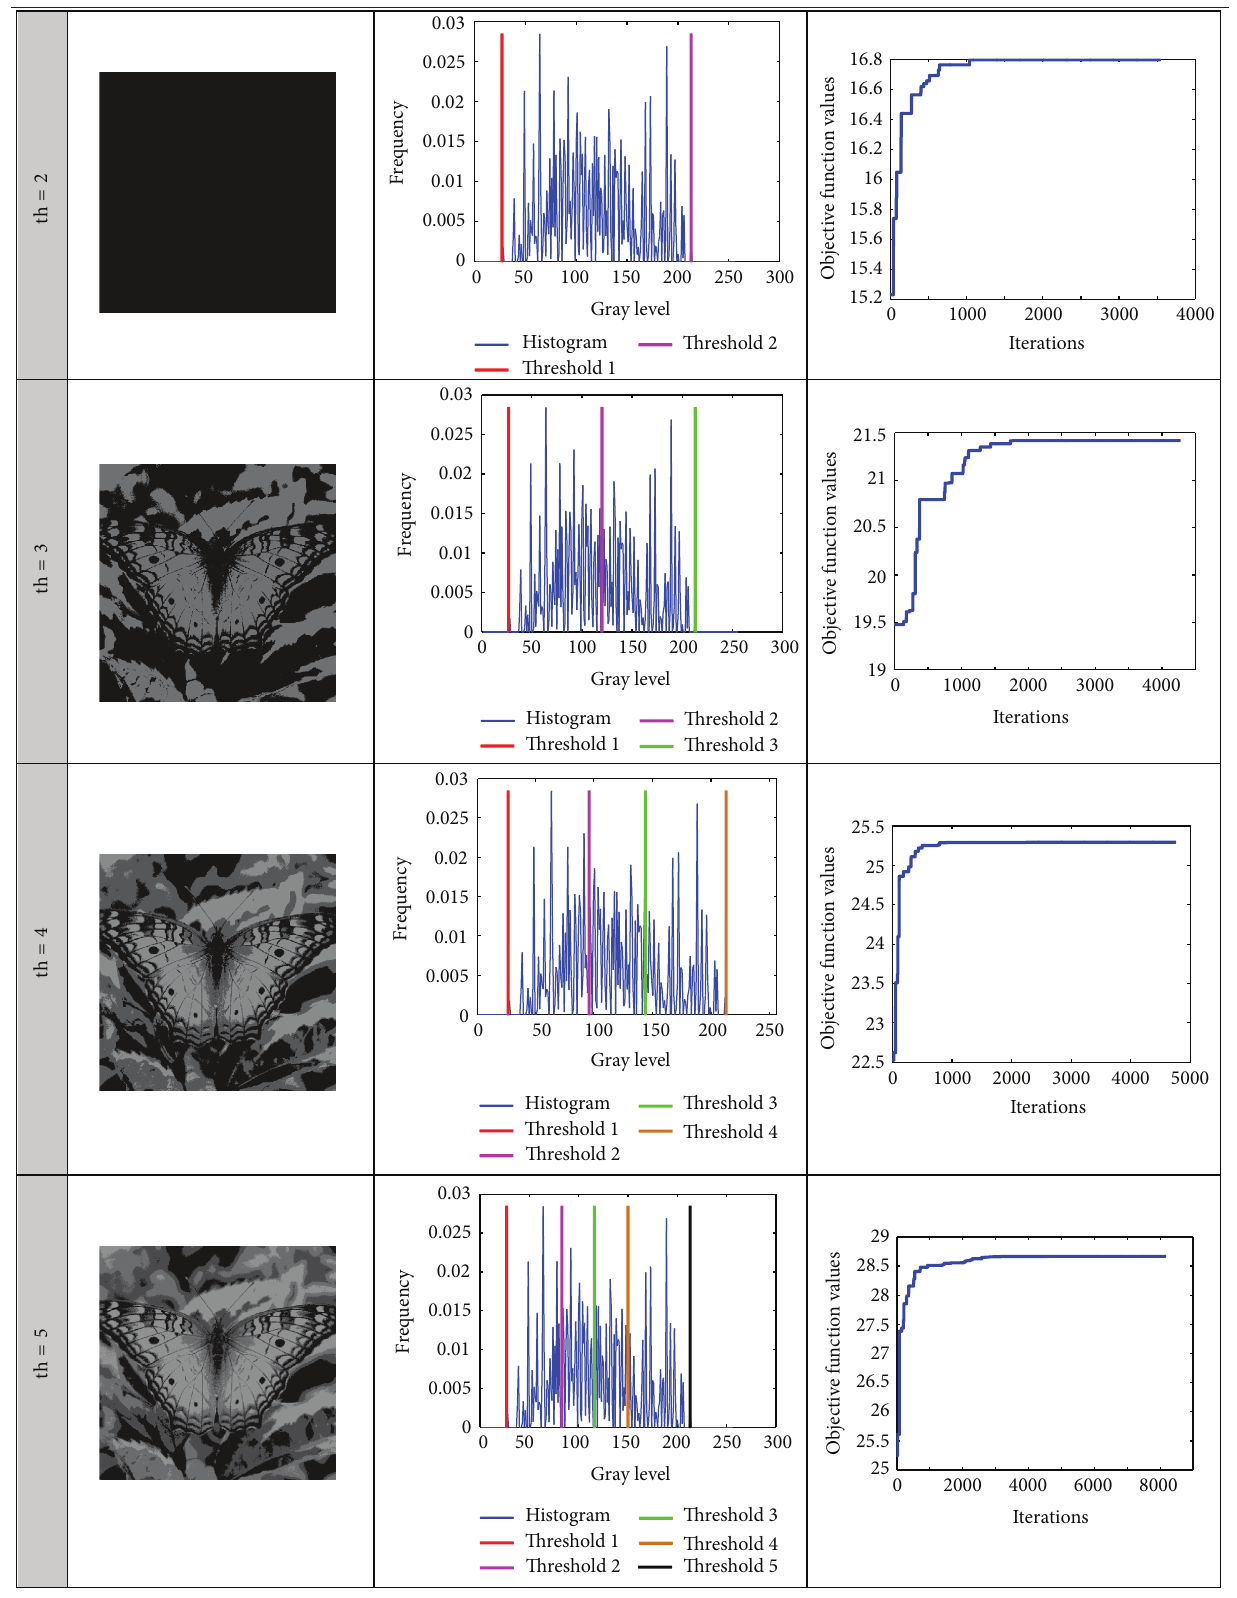
Table 14: Results after appling the HSMA using Kapur’s over the Butterfly